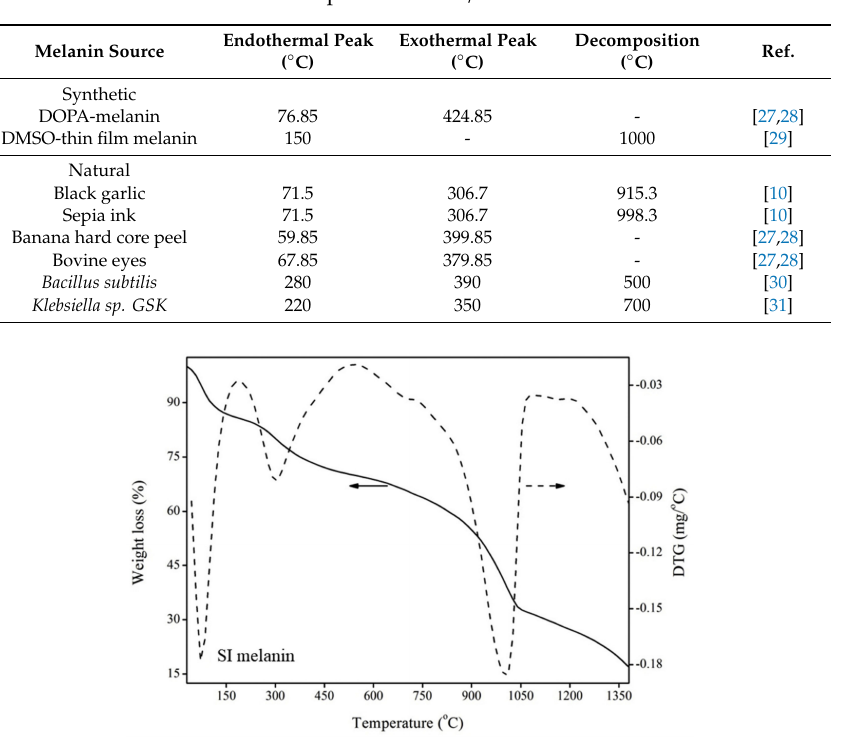
Table 2. Characteristic peaks on TGA / DTG curves of melanins.